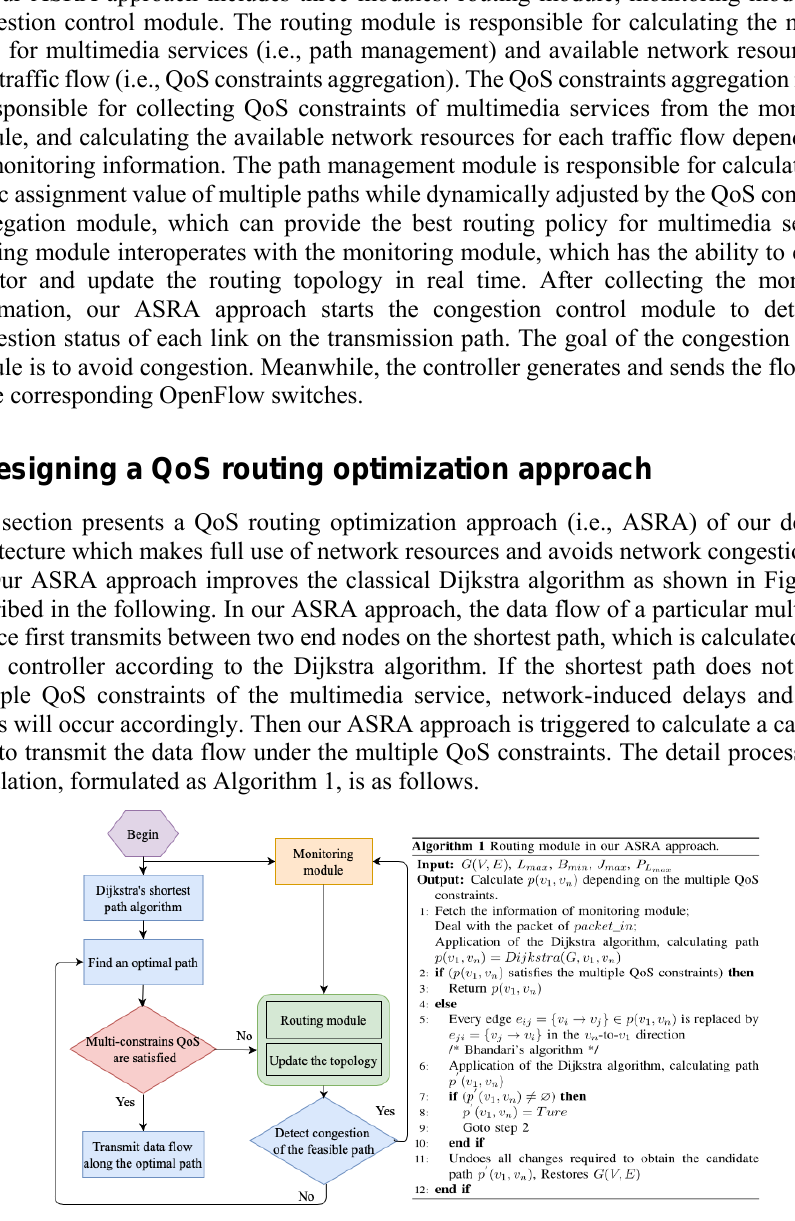
Fig. 2. The flowchart of our ASRA